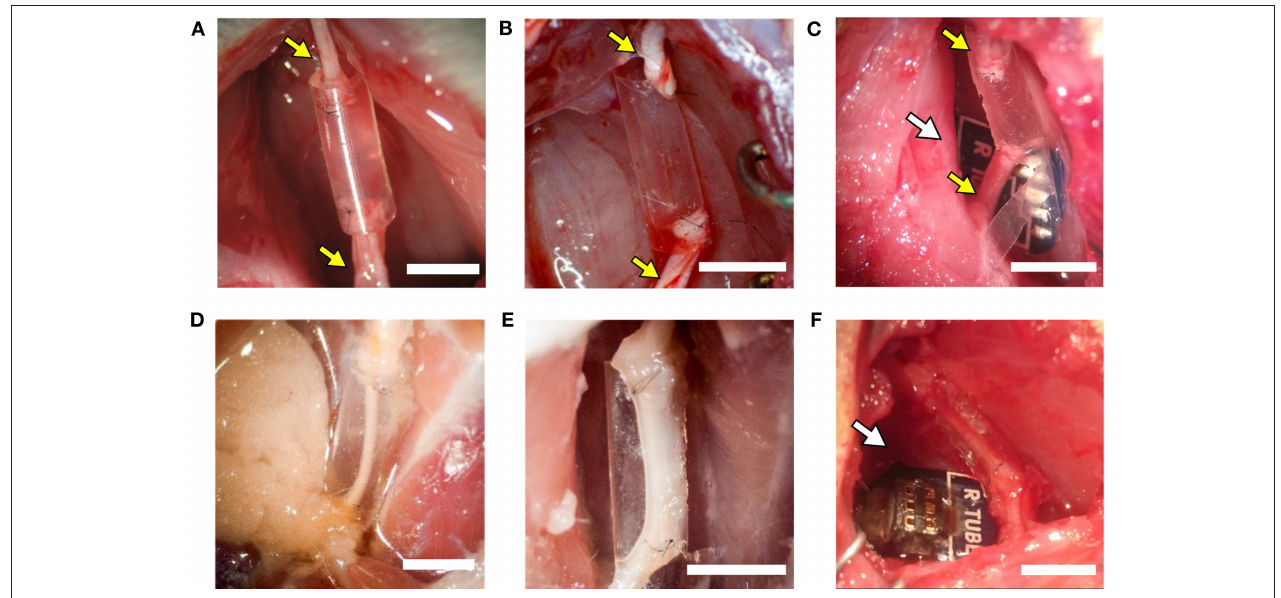
FIGURE 4 | The implanted regenerative cuff electrode. Representative images of: (A) silicone tube, (B) PEDOT:PSS coated PO tube (PPP tube), and (C) Regenerative nerve Cuff Electrode (RnCE) at the time of implant (0 dpi) bridging a 8mm gap in the rat sciatic nerve, and of (D) silicone tube, (E) PPP tube and (F) RnCE at 90 dpi, showing the regenerated nerve cable inside. Yellow arrows point proximal and distal sciatic stumps sutured to each device. White arrows point the PCB. Scale bar: